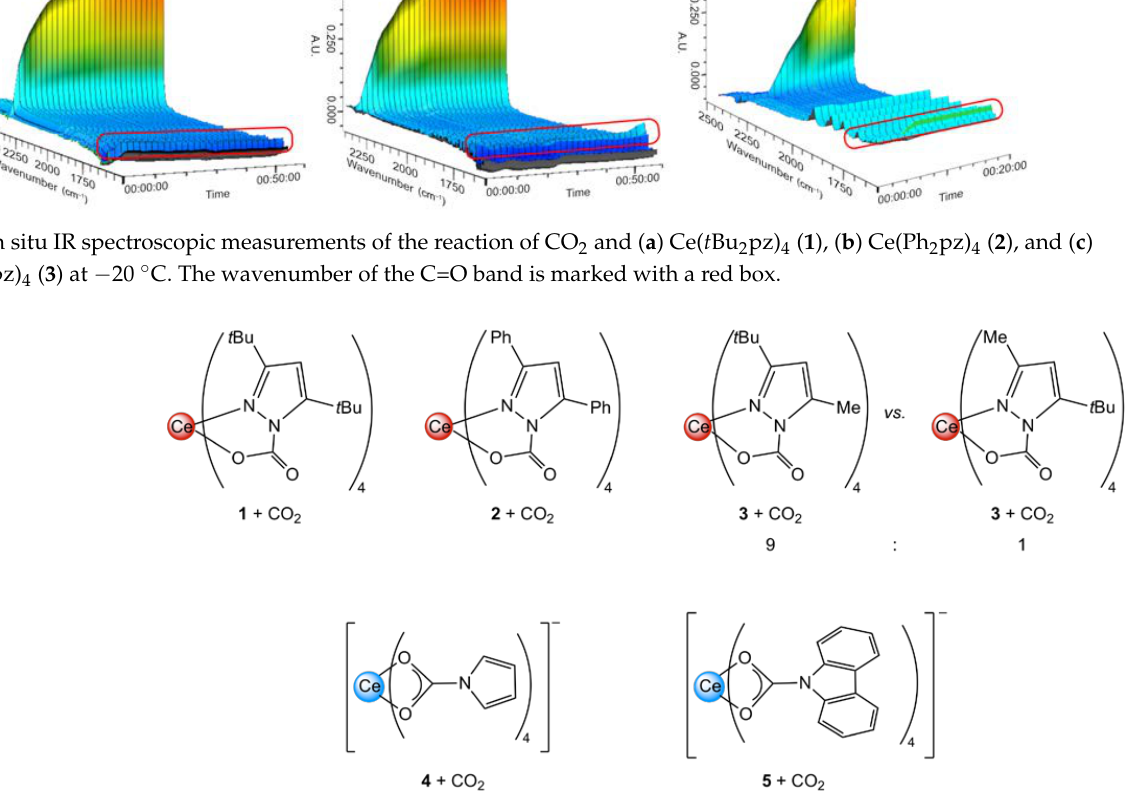
Figure 6. Putative insertion products of the reaction of complexes 1 to 5 with CO 2 . Similarly, pyrrole-derived complexes 4 and 5 were treated with CO 2 resulting in a shift of the signals in the 1 H NMR spectra (Figures S10 and S11, Supporting Information). For pyrrolate 4 , two broadened singlets were observed at 6.82 and 9.99 ppm, indicating the formation of a carbamato-like ligand CO 2 · pyr (Figure 6). Similar ligand formation was already found in the reaction of n BuLi, pyrrole, and carbon dioxide [76]. The 1 H NMR spectrum of the reaction of carbazolate 5 with CO 2 shows various paramagnetically broadened and shifted signals ruling out any conclusive interpretation. Nevertheless, the DRIFT spectra of the crude products, after removal of all volatiles under reduced pressure, clearly revealed an intense band for the C − O vibrations at 1600 to 1750 cm − 1 (Figure 7). This finding also indicated that, unlike [Ce(Me 2 pz) 4 ] 2 [38], the CO 2 insertion into the Ce − N(pyrrolato) bond is not reversible at ambient temperature under reduced pressure. Regrettably, a structural elucidation of the reaction products was not